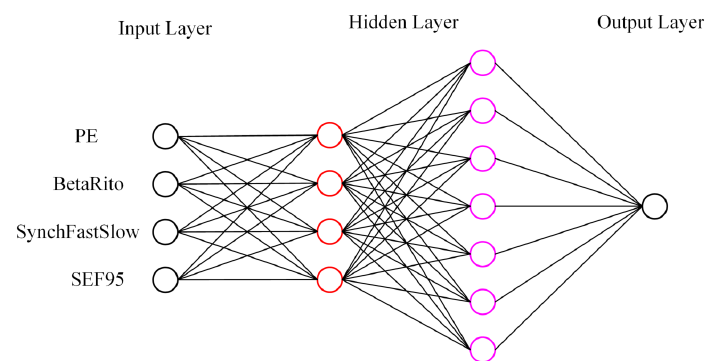
Figure 3. A schematic of the ANN structure used. One input layer with four nodes, the first hidden layer with four nodes, the second hidden layer with seven nodes, one output layer with one node.